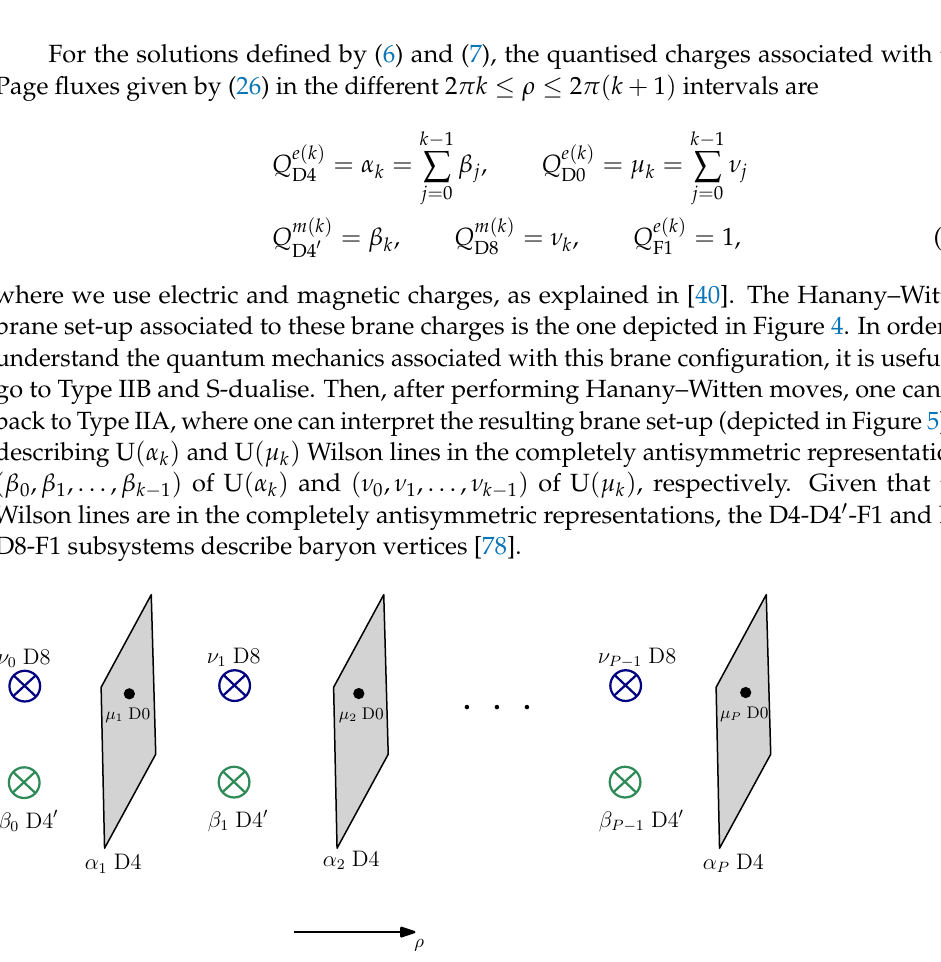
Figure 4. Hanany–Witten brane set-up associated with the brane charges of the solutions.